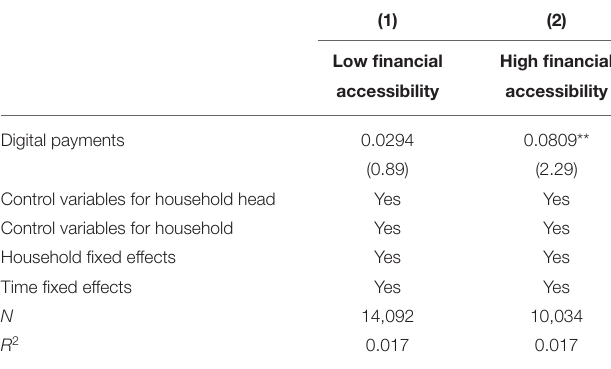
TABLE 9 | Heterogeneity of household financial